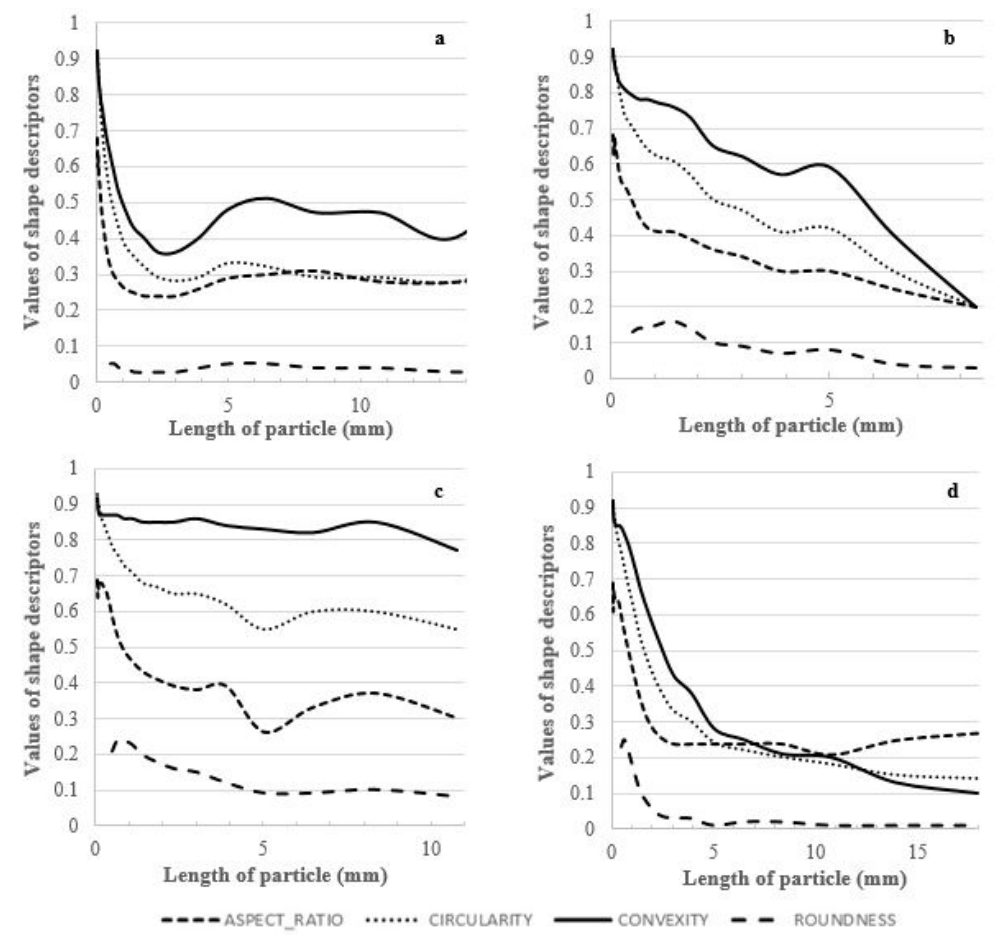
Figure 6. Particle shapes according to their length (Feret MAX , in µm) for ( a ) Wood fiber medium #3, ( b ) Irish white peat #5, ( c ) Composted pine bark ‘fine’ #18, and ( d ) Coir #22. Overall, decreases in values of shape descriptors and, thus, changes in shapes were observed according to an increasing particle length (Figure 6), except only roundness for wood fiber (cluster 1). Thus, the longer the particle, the more their width/length ratio (i.e., the less the aspect ratio), and the less their circularity, convexity, and roundness